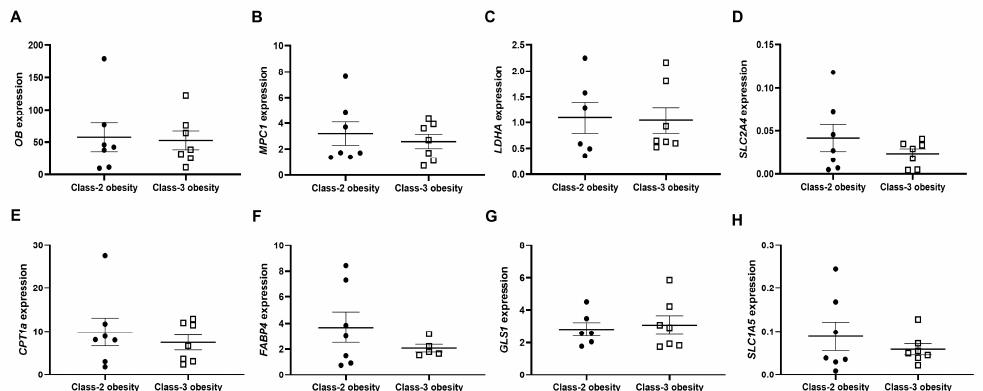
Figure 4. Expression of ( A ) OB ; ( B ) MPC1 ; ( C ) LDHA ; ( D ) SLC2A4 ; ( E ) CPT1a ; ( F ) FABP4 ; ( G ) GLS1 and ( H ) SLC1A5 genes in VAT pertaining to patients with obesity classes 2 and 3. ( OB